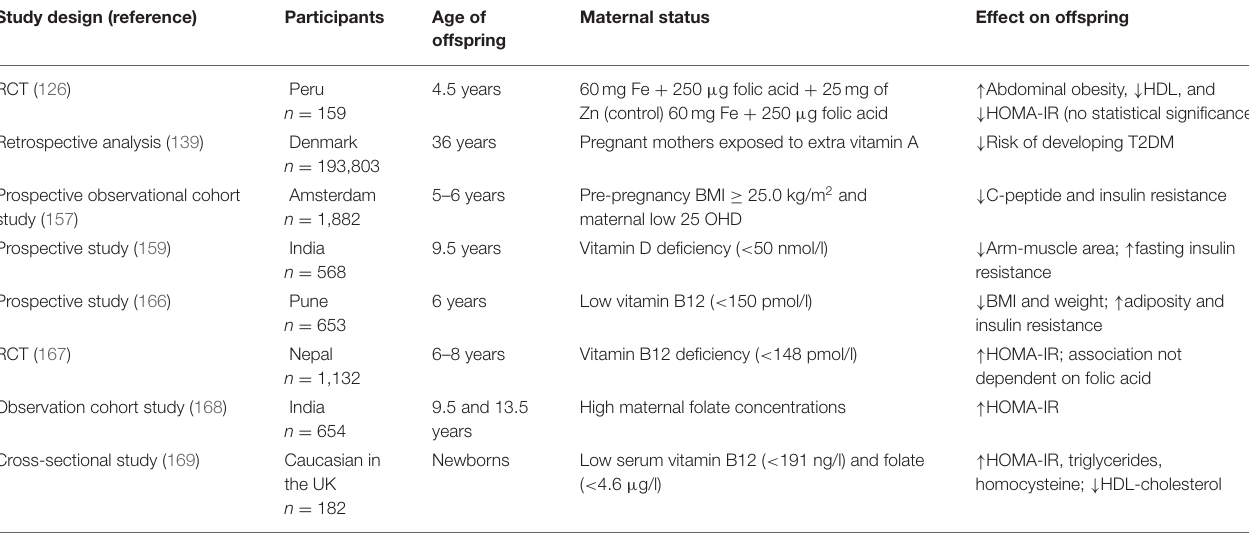
TABLE 1 | Charting the maternal micronutrients status and the effect on glucose metabolism in